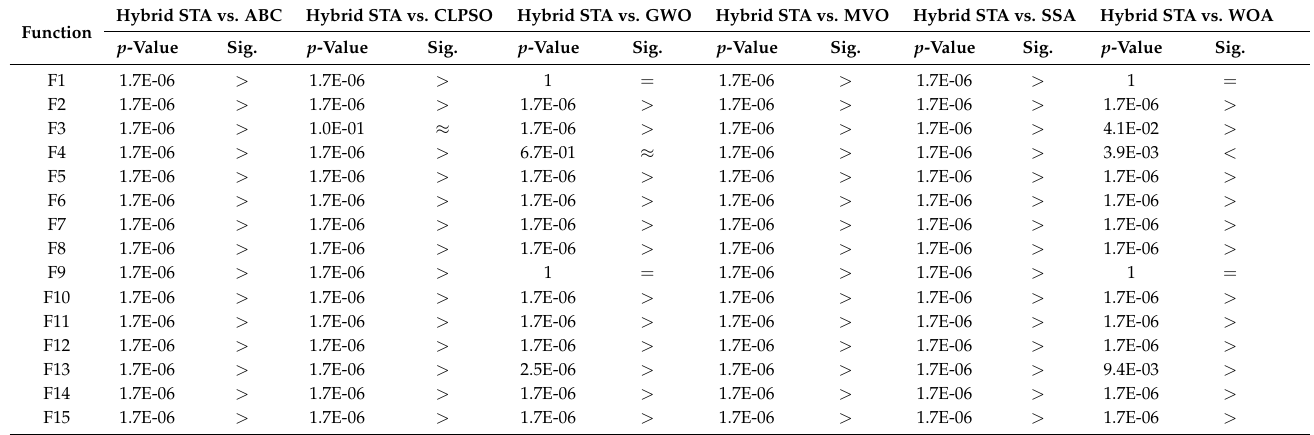
Table 11. Wilcoxon signed-rank test in 50 dimensions.